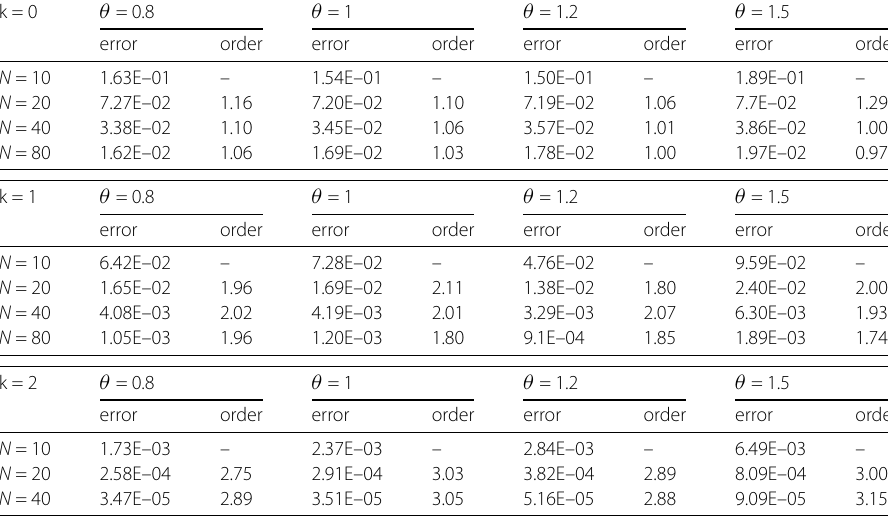
Table 1 The L 2 -norm error estimates at T = 1